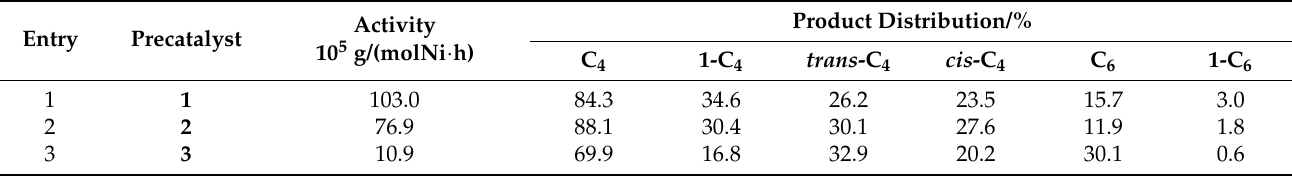
Table 1. Ethylene oligomerization with PNP(NR 2 ) 2 -based precatalysts 1 – 3 a .